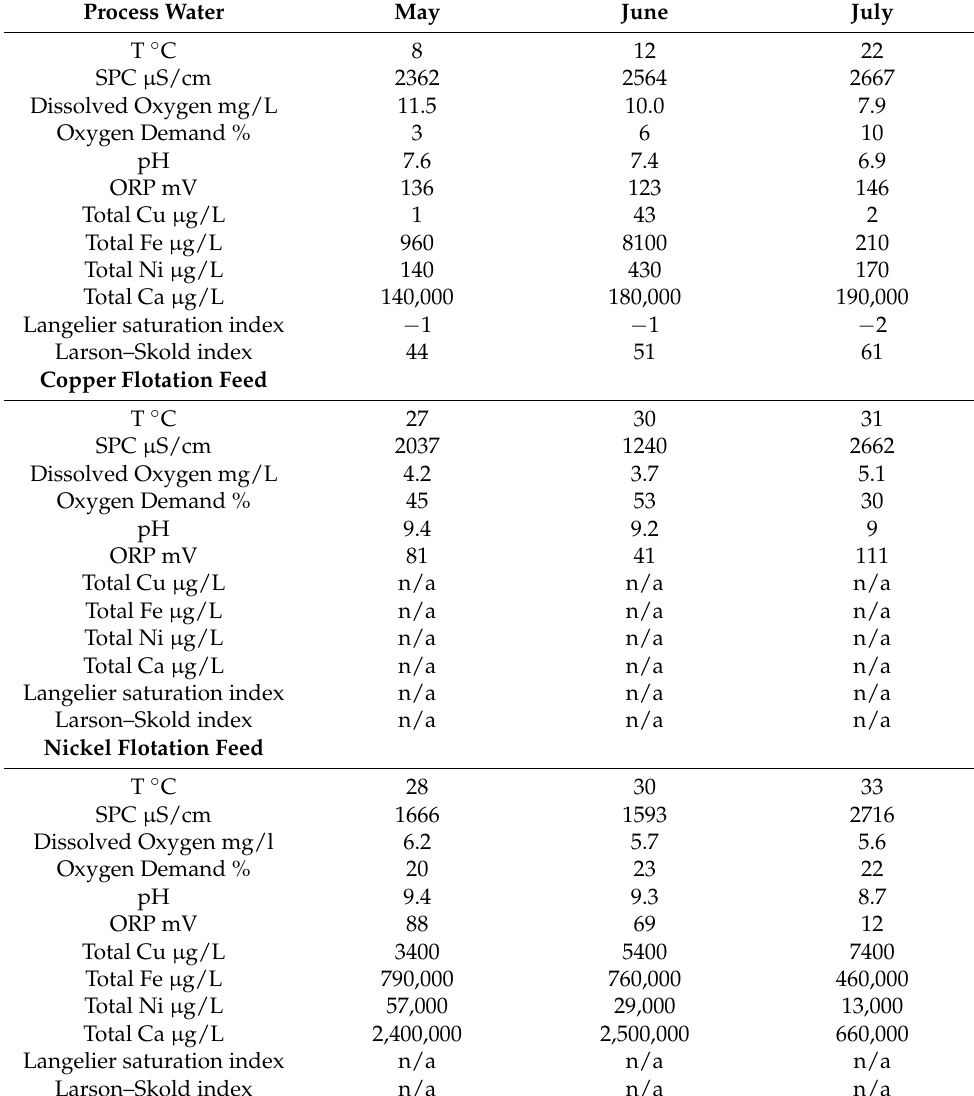
Table 3. Physicochemical parameters and elemental compositions of water and slurry